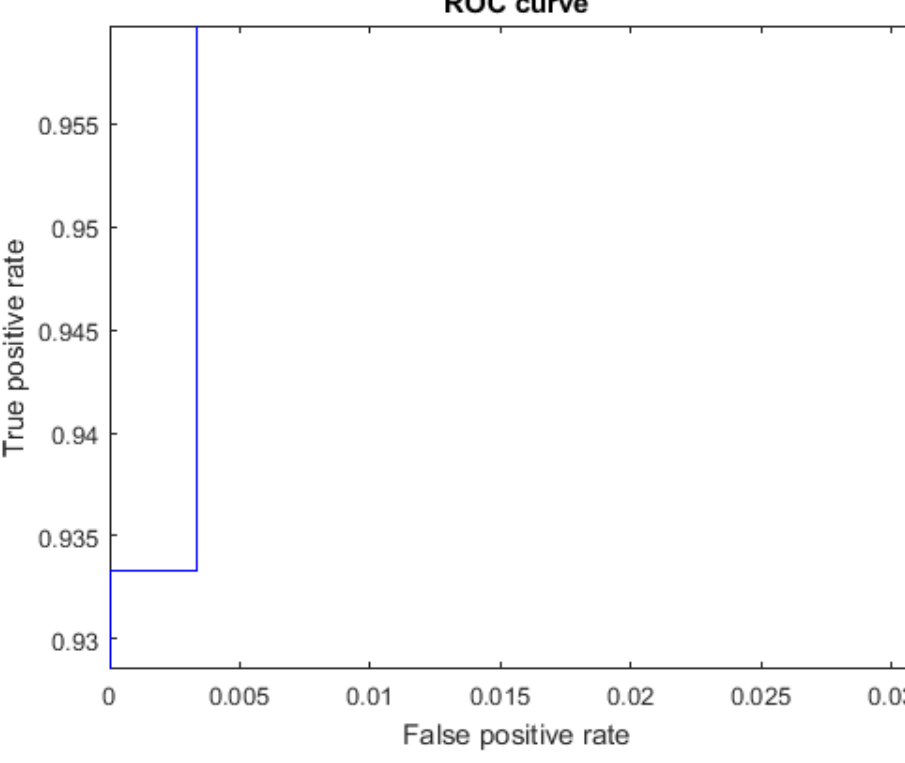
Figure 16. ROC curve for the letter R using Cartesian features, AUC = 0.9998.